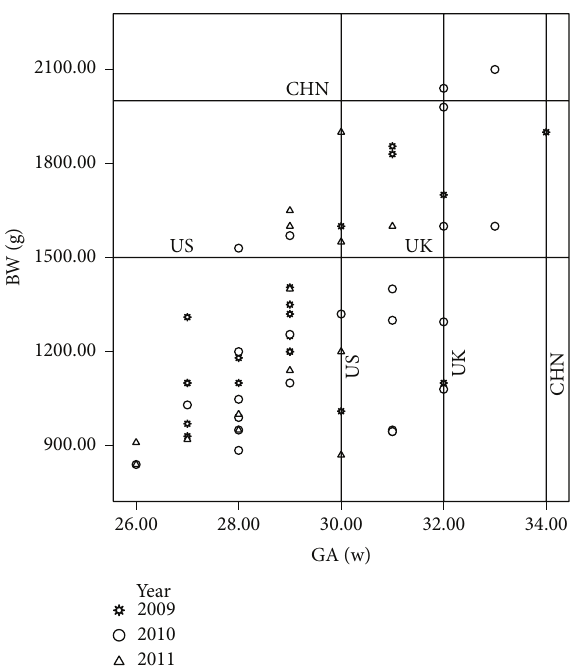
Figure4:ThemeantimeforcontinuousoxygentherapyofROPand non-ROP infants in 2009, 2010, and 2011. Figure 5: The distribution of type I ROP needing treatment according to the GA and BW in 2009, 2010, and